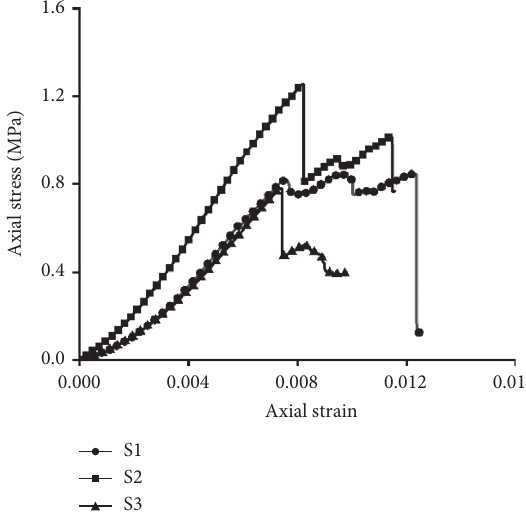
Figure 2: Stress-strain curve: static tensile test.